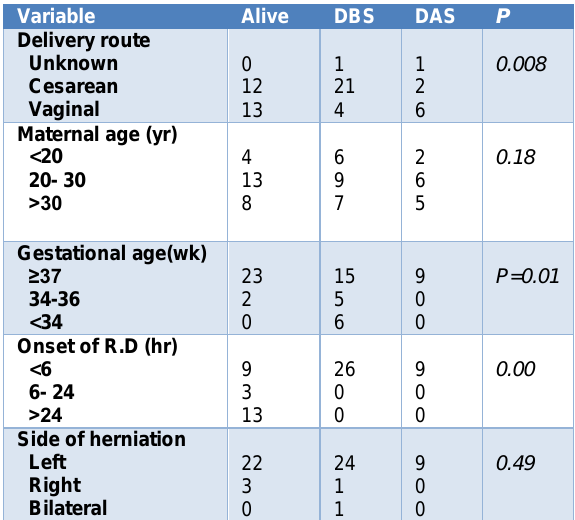
Table 4. Patients characteristic effect on the